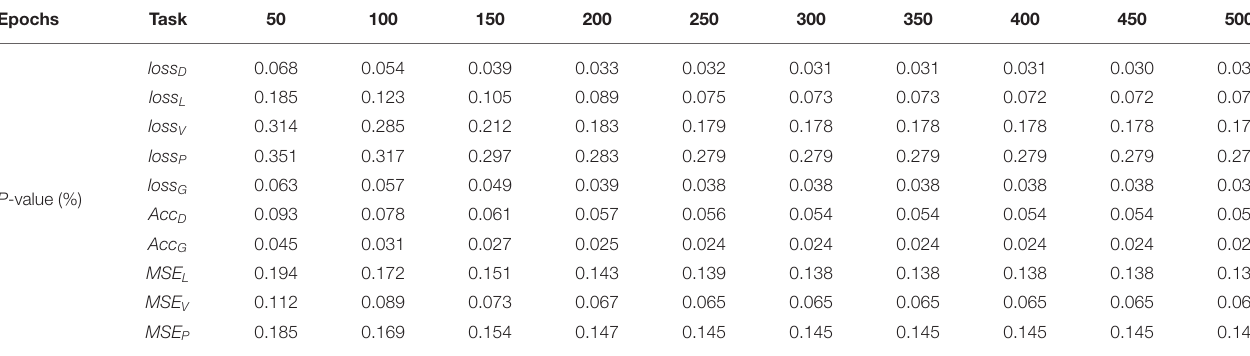
TABLE 2 | T -test results on the performance of multiple tasks at different epochs. Epochs Task